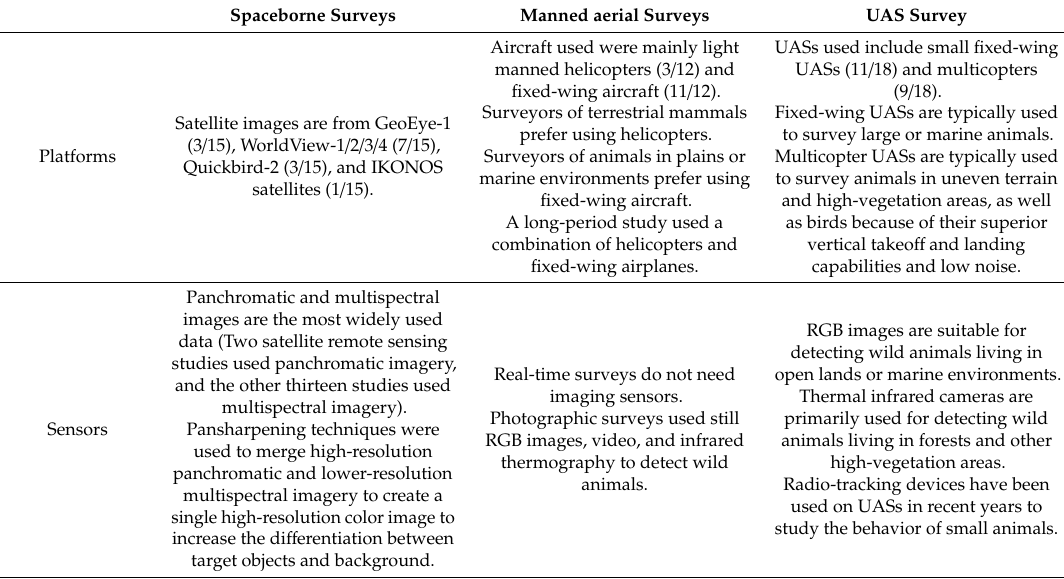
Table 1. Comparison of spaceborne, manned aerial, and unmanned aircraft system (UAS) surveys of wild